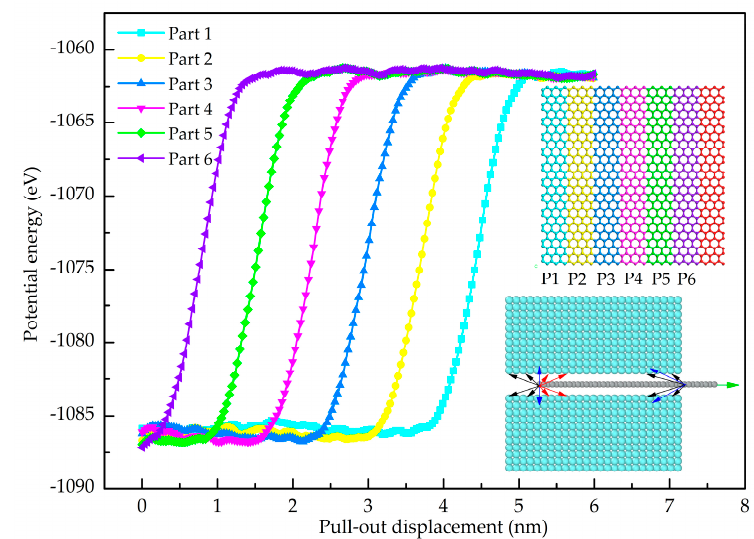
Figure 8. Potential energy increment of the different Al crystal orientations during pull-out test.